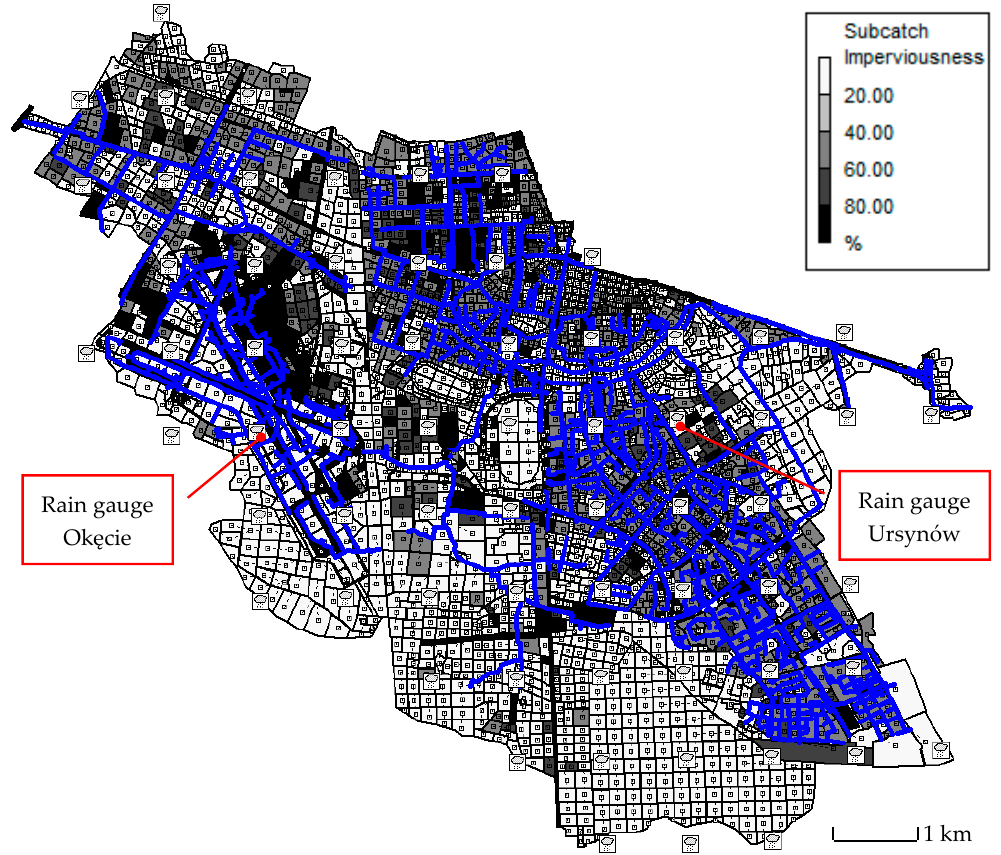
Figure 2. The storm drainage system, subcatchments and rain gauges (two existing and 64 virtual objects) in the SWMM (Storm Water Management Model) model for the studied area.